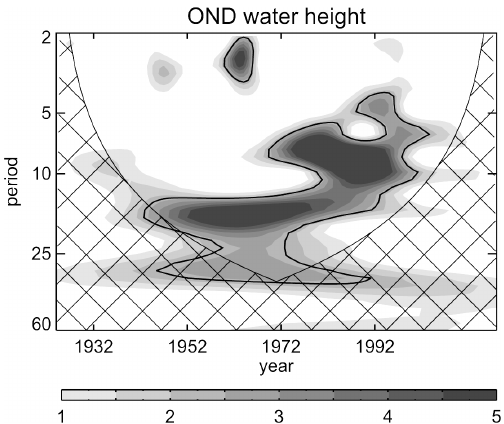
Figure C1. Wavelet of time series of the autumn (October–November–December) mean water height for 1924–2018, expressed as power values normalized by the variance. Seasonal values are obtained from monthly means of the daily series. Less than 10% of days are missing for all months of this period. Significant power density at 90% confidence level is highlighted by contours. This figure follows the same approach adopted in Barriopedro et al. (2010), which considered the much shorter 1948–2008 period.